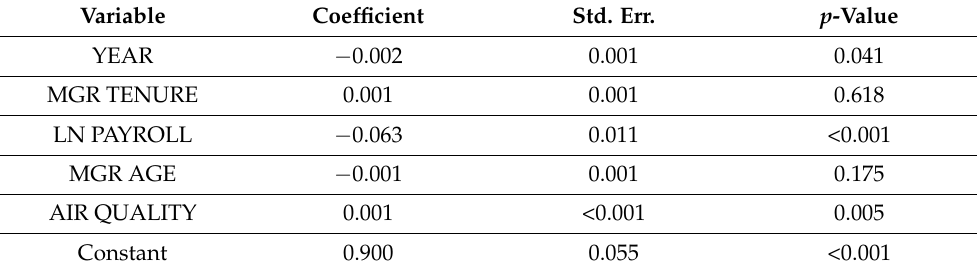
Table 3. Regression results of air quality as a predictor of MLB